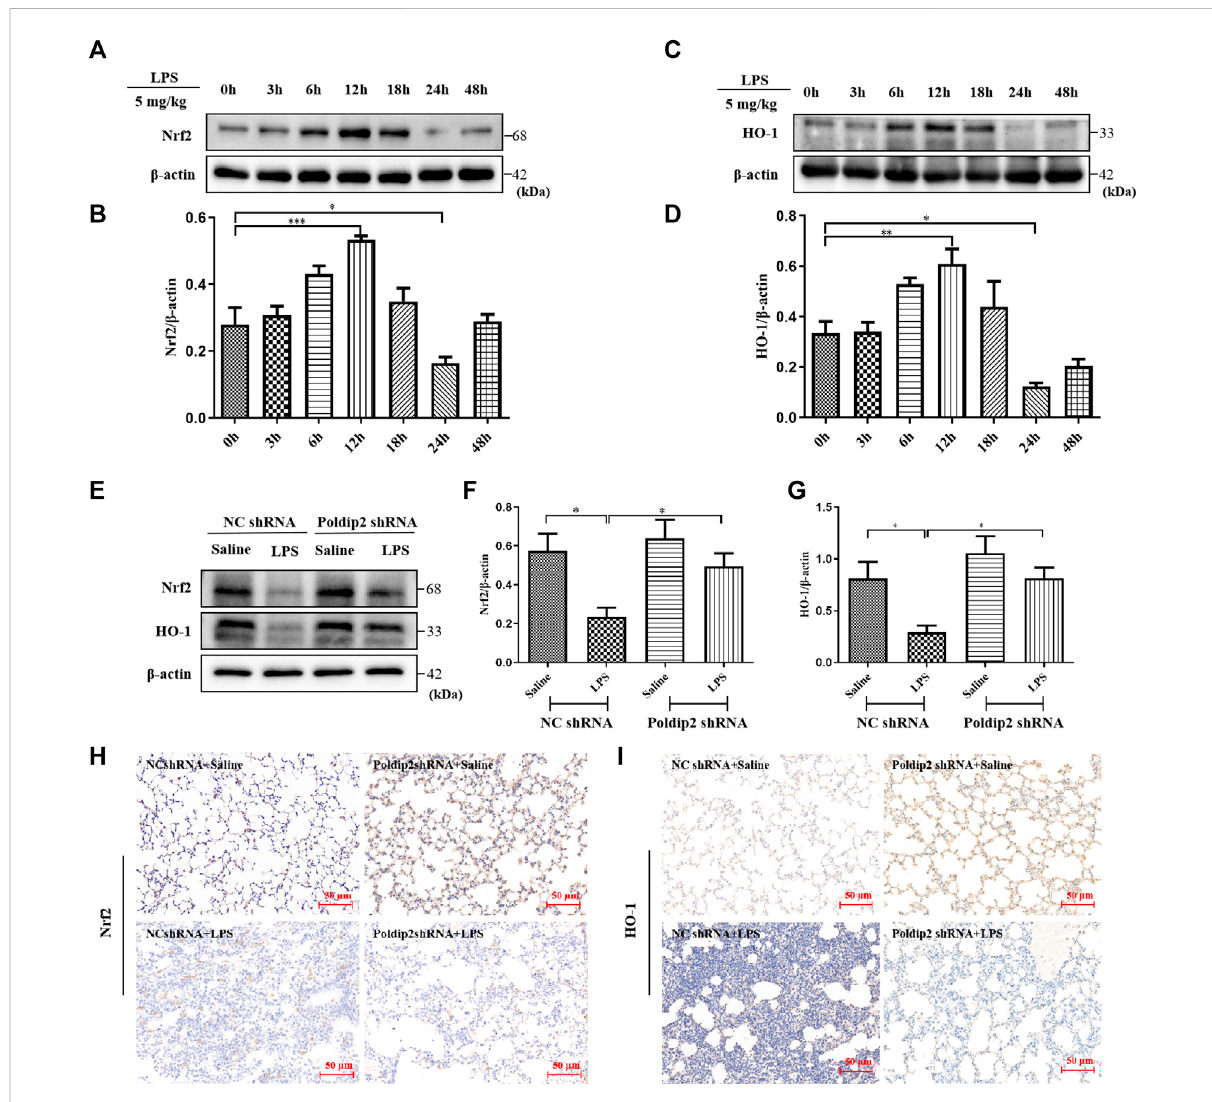
FIGURE 3 Poldip2knockdowninhibitsLPS-inducedALIthroughactivatingNrf2signalingpathway.MaleC57BL/6micewereintratracheallyatomizedwith 5 mg/kg of LPS for different times (0 – 48 h) (A – D) . The protein levels of Nrf2 and HO-1 were detected by western blot (A,C) and quantitatively analyzed (B,D) . Male C57BL/6 mice were intratracheally atomized with AAV6 vector expressing Poldip2 shRNA or NC shRNA. Thirty- fi ve days later, 5 mg/kg of LPS or saline was given via intratracheal atomization for 24 h (E – G) The protein levels of Nrf2 and HO-1 were detected by western blot (E) and quantitatively analyzed (F,G) (H,I) Representative images showing immunohistological staning of Nrf2 and HO-1 (magni fi cation, ×200). Scale bars are 50 μ m n = 6 mice per group. Results are represented as mean ± SEM. Statistically signi fi cant differences are indicated as *** p < 0.001,** p < 0.01, * p <